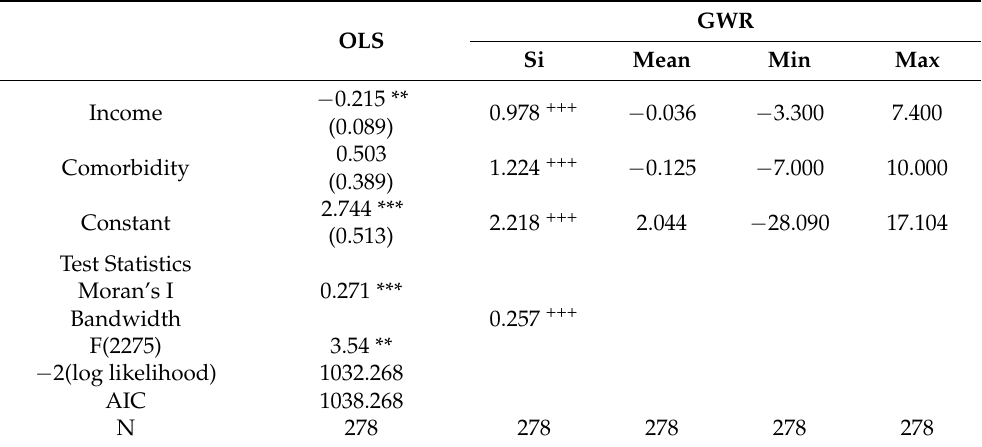
Figure 3. Space-time clusters of the elderly living in Residential care homes between 3 March and 31 December 2020. Table 3. Geographically Weighted Regression Estimation of Elderly COVID-19 Relative Risk in Portuguese municipalities between 3 March and 31 December